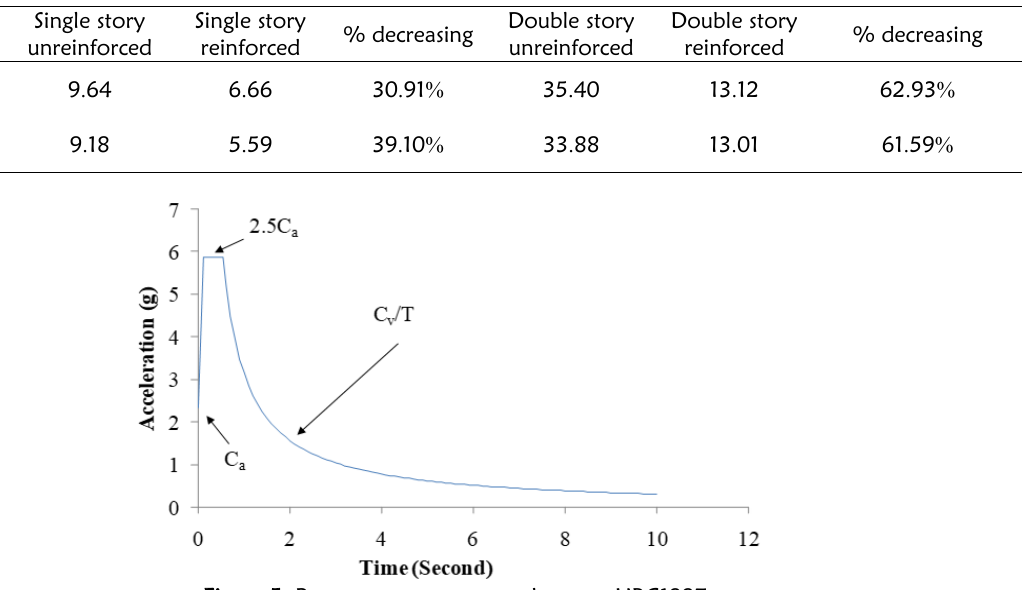
Figure 5: Response spectrum graph as per